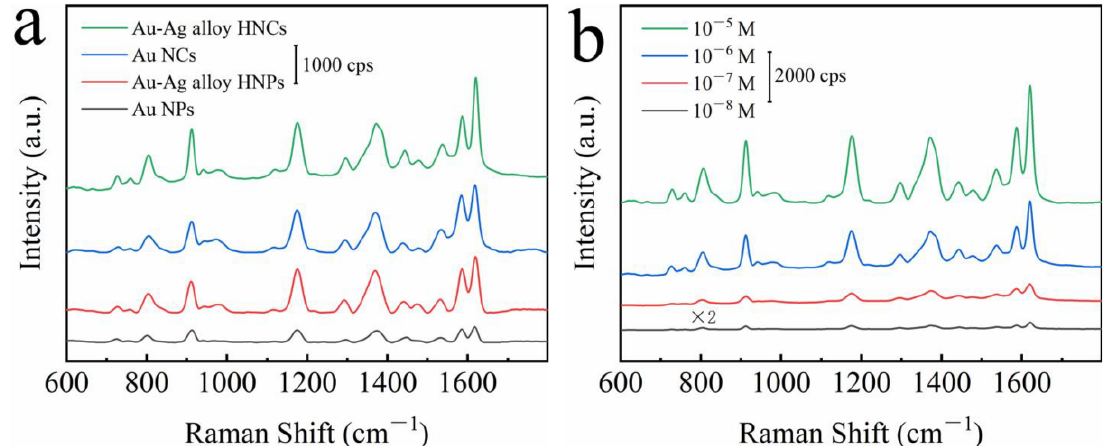
Figure 4. ( a ) The SERS spectra of 10 − 6 M CV adsorbed on Au NPs, Au NCs, Au–Ag alloy HNPs and Au–Ag alloy HNCs. ( b ) SERS spectra of CV molecules with different concentrations (10 − 5 − 10 − 8 M) adsorbed on Au–Ag alloy HNCs.